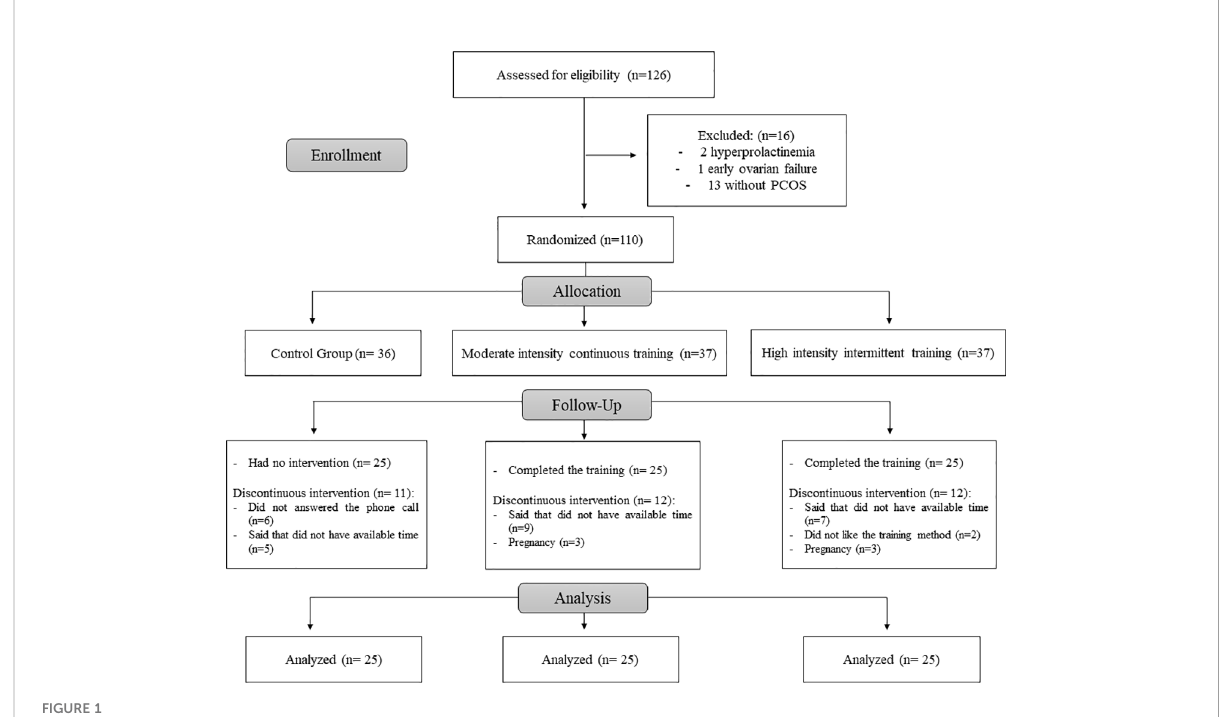
FIGURE 1 A fl ow diagram of the